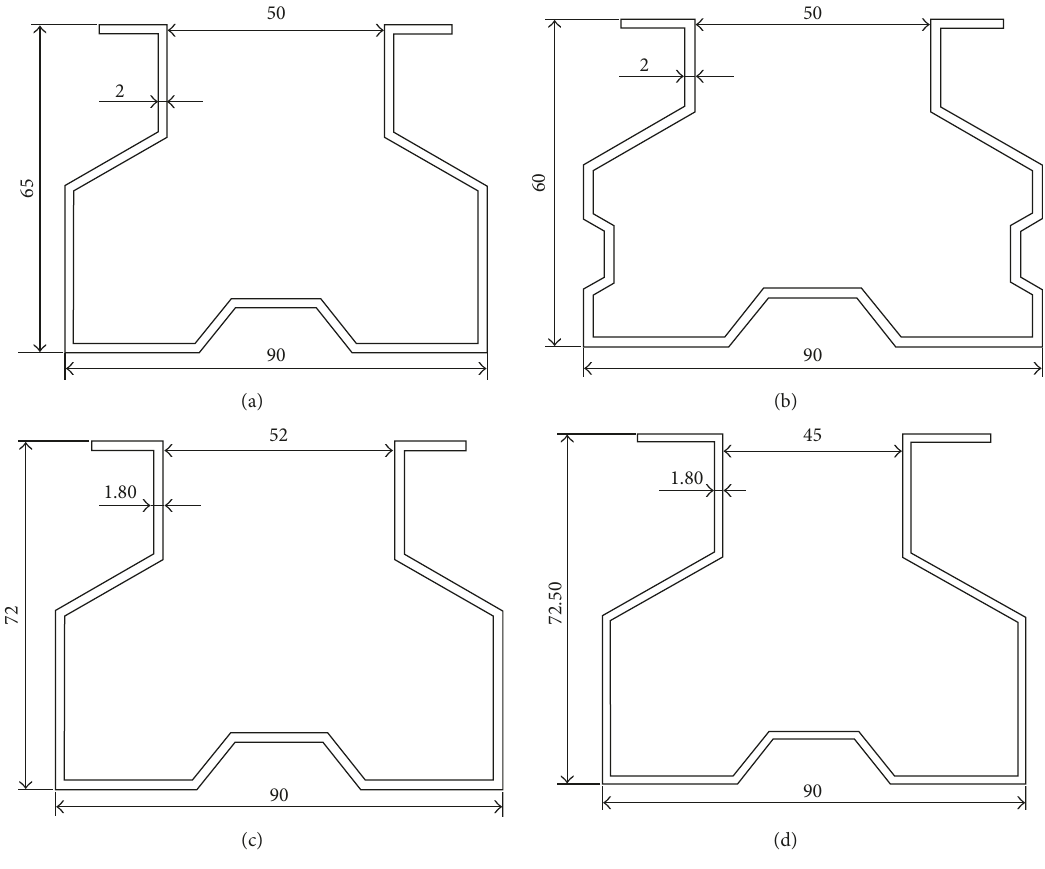
Figure 18: Sections of sample (unit: